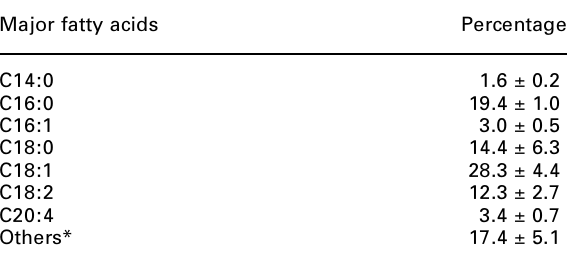
Table 1. Fatty acid composition of human bone marrow mononuclear cells. Data (mean ± SEM of four independent samples) are reported as the percentage of fatty acid species Major fatty